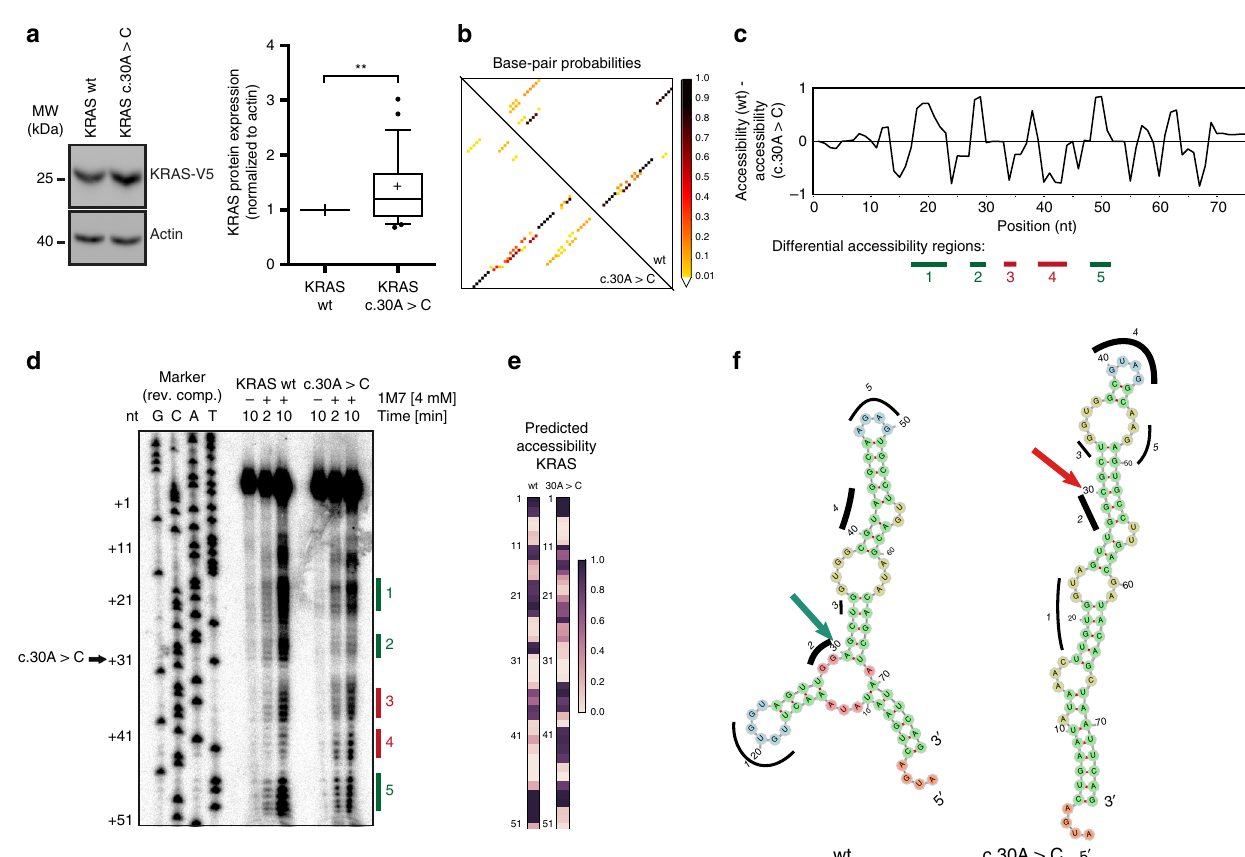
Fig. 6 KRAS c.30 A > C affects the transcript secondary structure. a Left: HEK293 cells were transfected with the indicated KRAS-V5 constructs. Expression of the constructs was evaluated by western blotting using anti-V5 and anti-Actin antibodies. Left: a representative experiment is shown. Right: quanti fi cation of the western blot from biological replicates ( n = 25). V5 signals were normalized to Actin signals presented as boxplot. ** p < 0.01 ( t -test). b Base-pairing probabilities of the wildtype and mutant sequences are shown. The mutation introduces a stable rod-like duplex (bottom-left), while the stable structure in the wildtype forms branching stems (top-right). c The change in nucleotide accessibility is depicted by the difference between the predicted accessibility along the KRAS wildtype vs. mutant transcripts. d In vitro SHAPE probing of KRAS wildtype (WT) and c.30 A > C mutant KRAS using 1M7 shows differential nucleotide accessibility pro fi les. Lanes 5 – 7 and lanes 8 – 10 indicate the SHAPE pro fi le of wildtype KRAS and mutant KRAS (c.30 A > C), respectively. RNA shown in lanes 5 and 8 are treated with DMSO for 10 min and lanes 6/9 and lanes 7/10 correspond to RNA treated with SHAPE reagent 1M7 (4 mM fi nal concentration) for 2 min and 10 min, respectively. Numbered rectangular boxes correspond to regions of predicted local structural accessibility changes as shown in Fig. 6c. Lanes 1 – 4 represent the sequencing ladder prepared from KRAS DNA as template in complementary sequence. e Heatmaps of nucleotide-wise accessibility predicted in silico for comparison with SHAPE. f Representation of the secondary structures with minimum free energy by RNAfold for KRAS wildtype and mutant RNAs used for